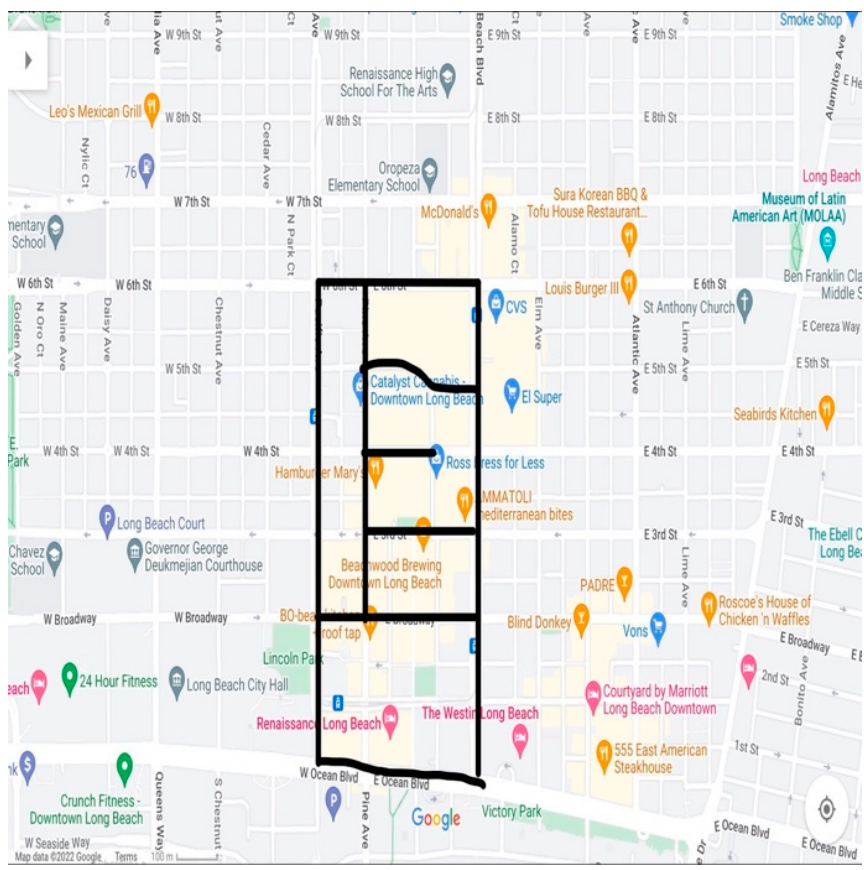
Figure 1. Path walked in Downtown Long Beach.